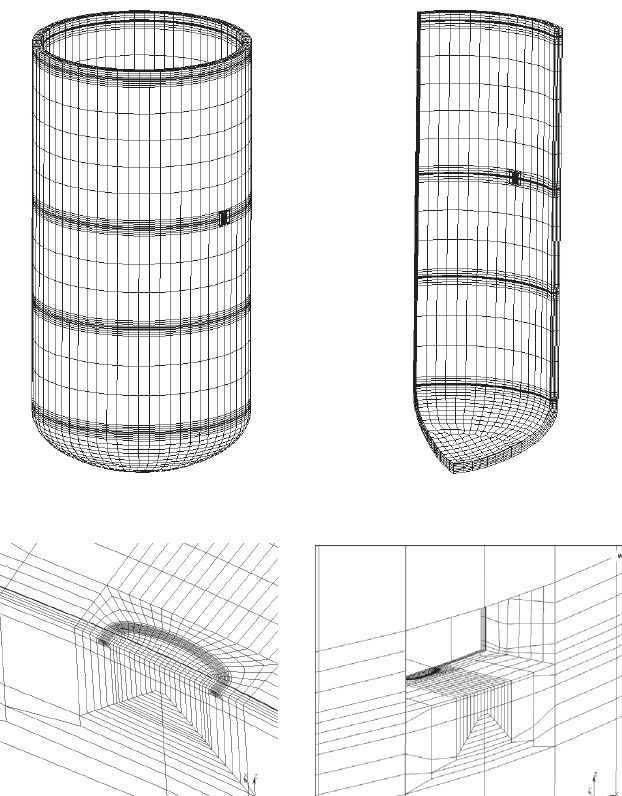
Figure 5: 3D Finite element model of a lower cylindrical part with embedded crack of a VVER-440 RPV. Description of neutron-transport